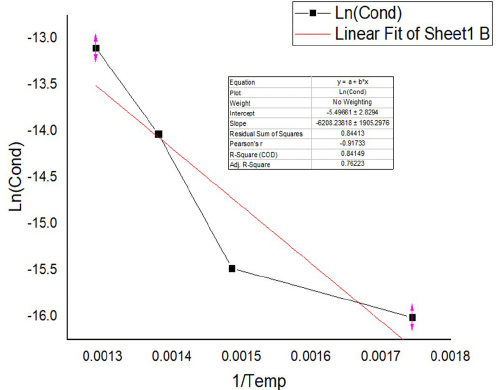
Figure 12. Arrhenius Plot for Composition 9